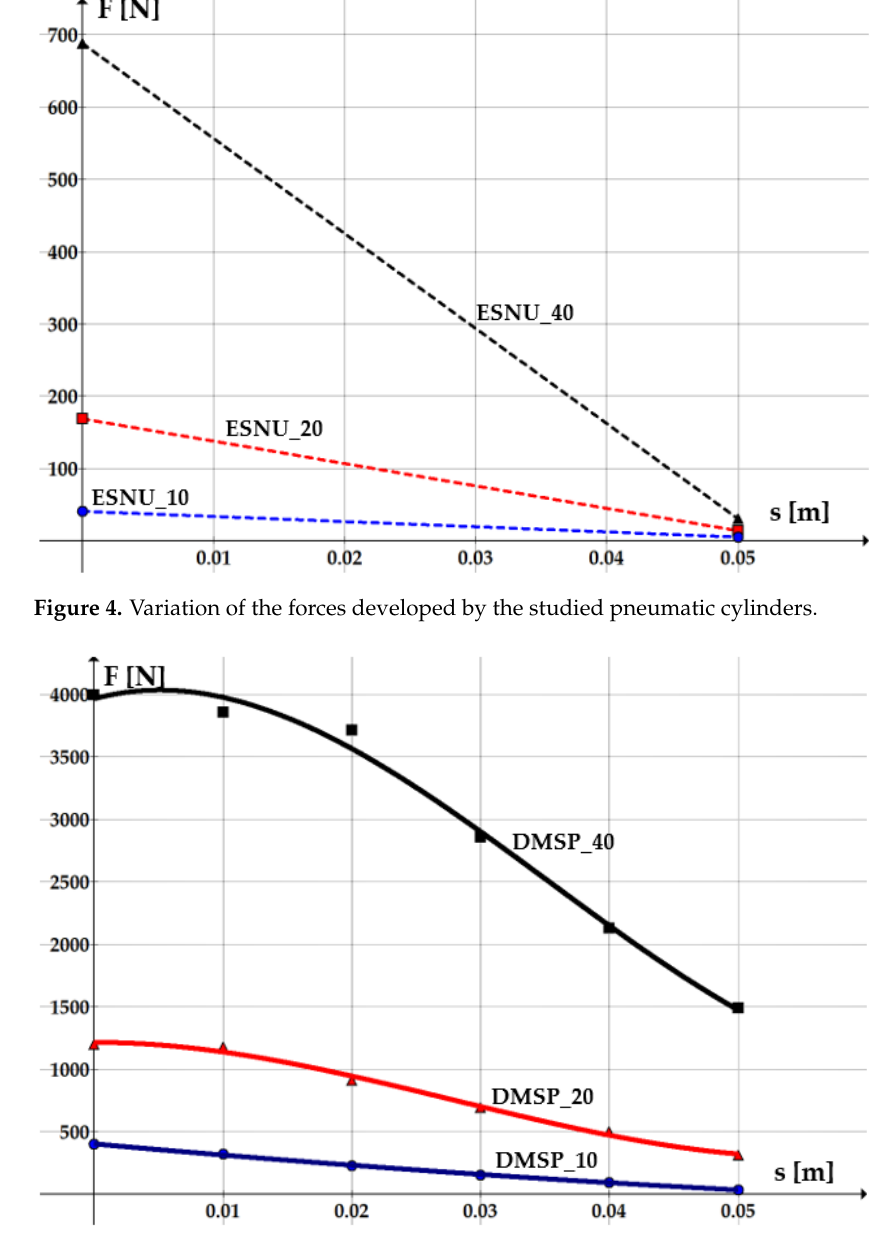
Figure 5. Variation of the forces developed by the studied pneumatic